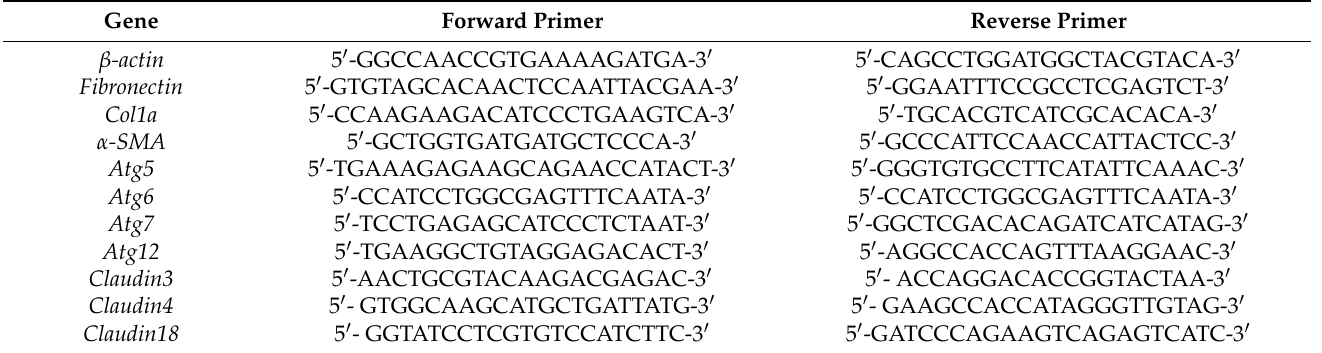
Table 1. Sequences of primers for quantitative